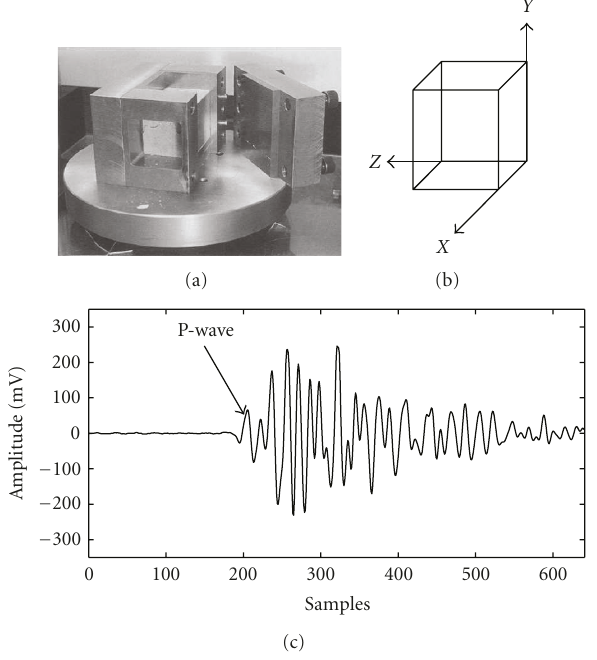
Figure 2: (a) Experimental setup for recording the AE events in a surface instability test. (b) Coordinate axes of the setup. (c) AE event recorded from the first sensor that triggers the data acquisition process. The P-wave is indicated with an arrow; it is the first component that arrives at the sensor and used for time of arrival